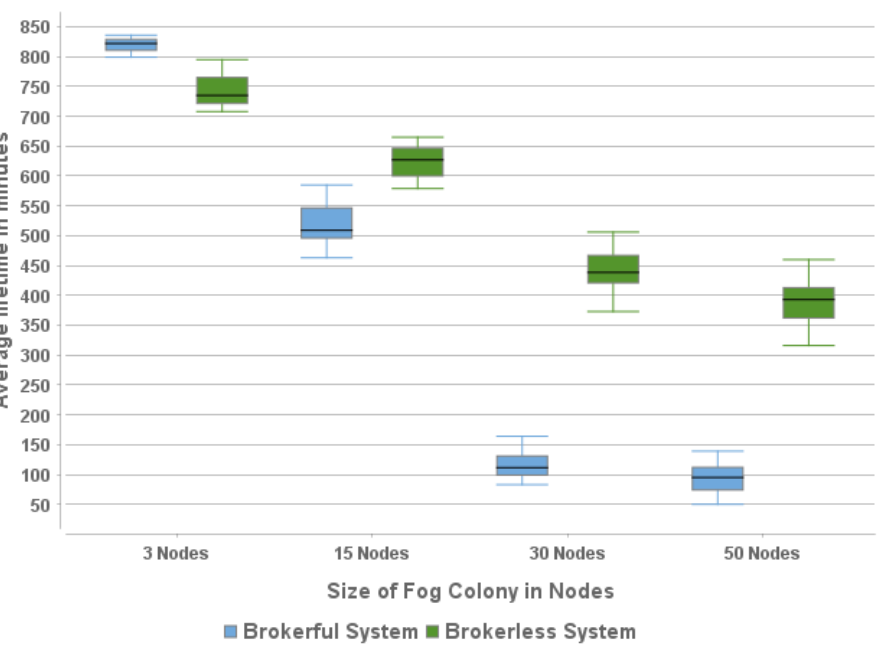
Figure 8. Box chart showing the comparison on the lifetime per node between the two Fog Colony